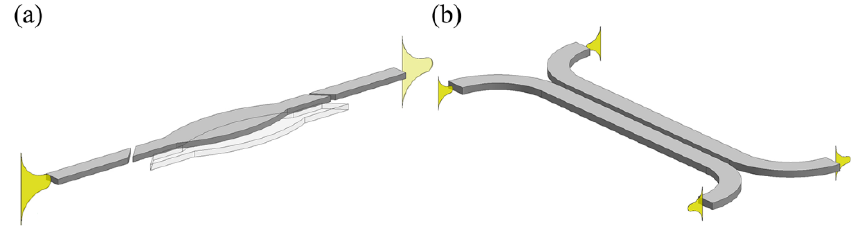
Figure 1. Schematics of ( a ) segmented waveguides and ( b ) coupled waveguides configuration.